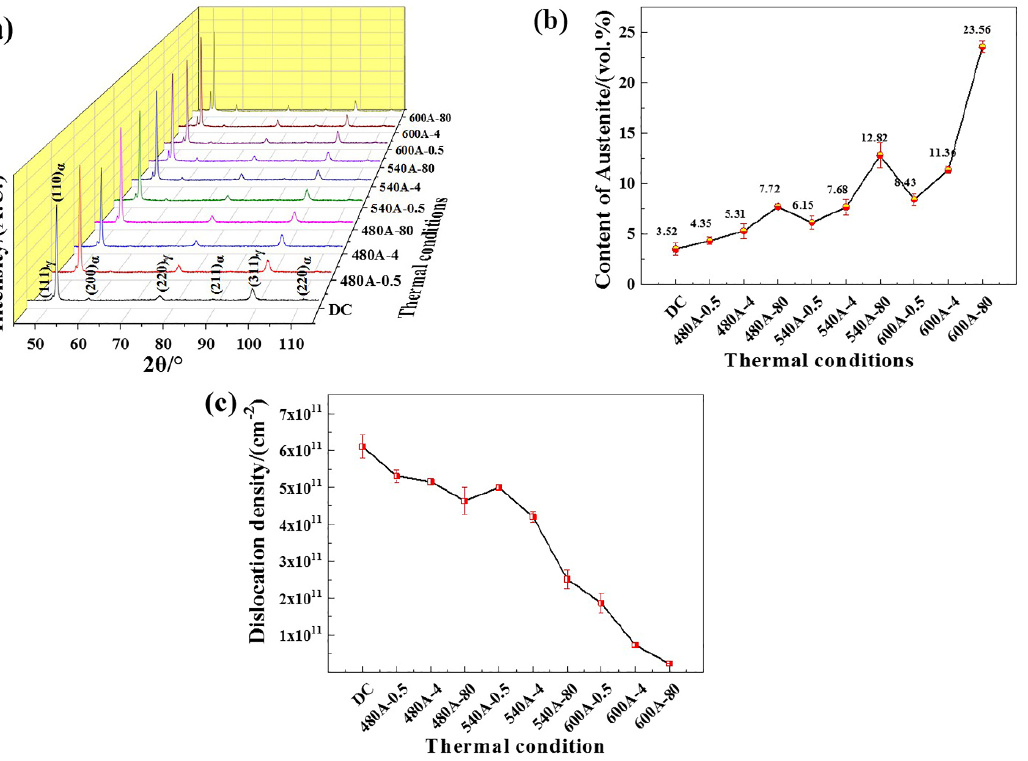
Figure 2. XRD analysis of the 444specimens under various thermal conditions: ( a ) XRD diffraction pattern, ( b ) volume fraction of austenite determined by XRD, and ( c ) dislocation density determined pattern, ( b ) volume fraction of austenite determined by XRD, and (c ) dislocation density determined by by XRD.